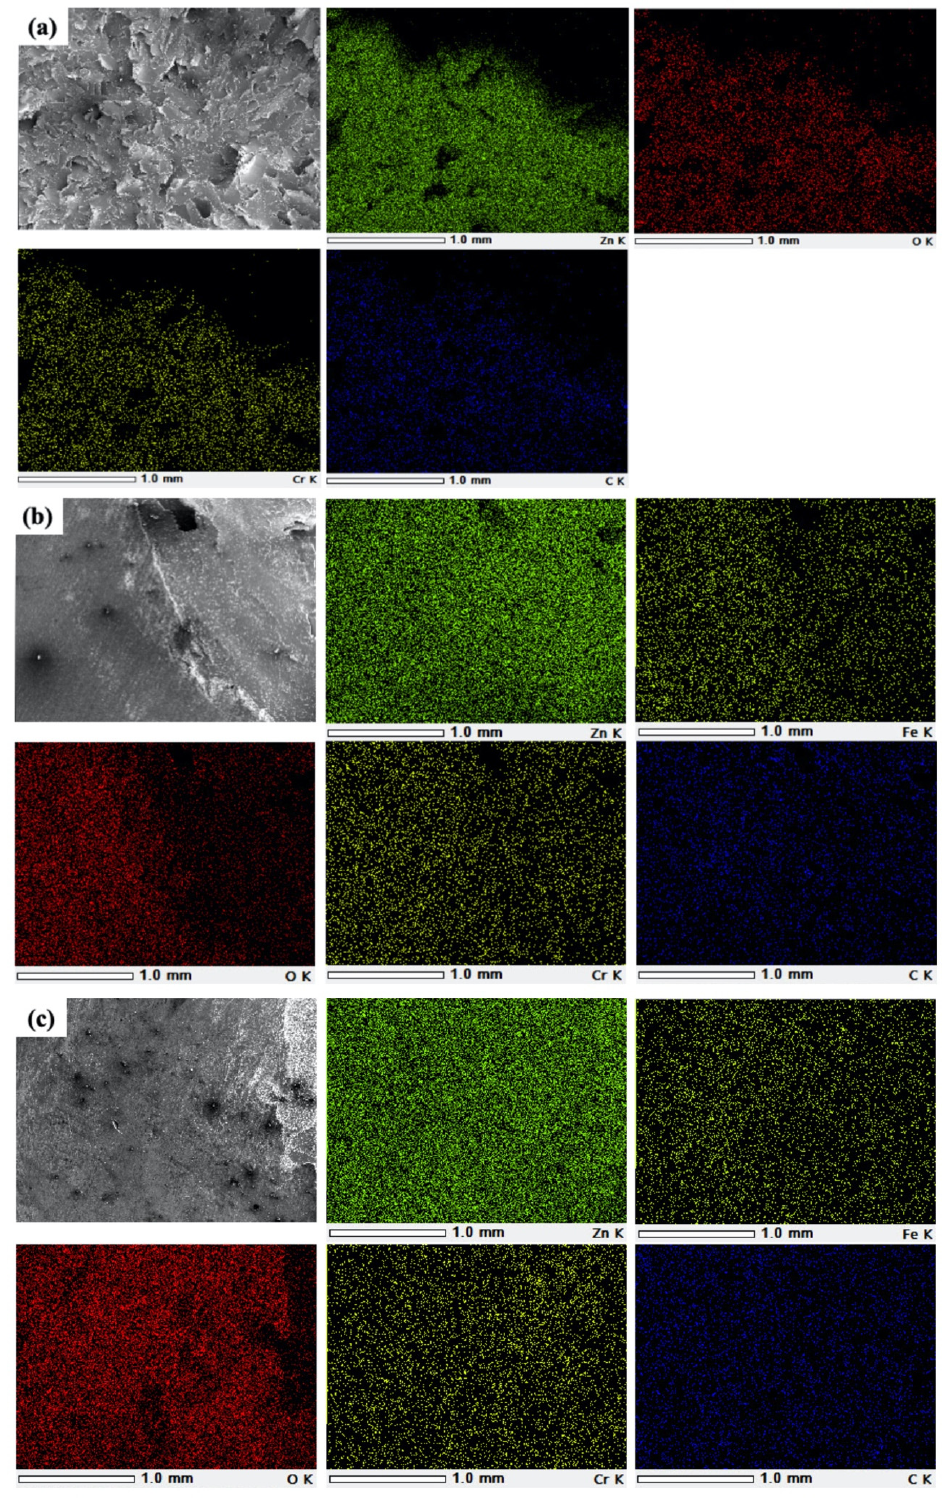
Figure 9. EDS map analysis: ( a ) 35 s—100 °C sample, ( b ) 35 s—150 °C sample, and ( c ) 35 s—200 °C sample.